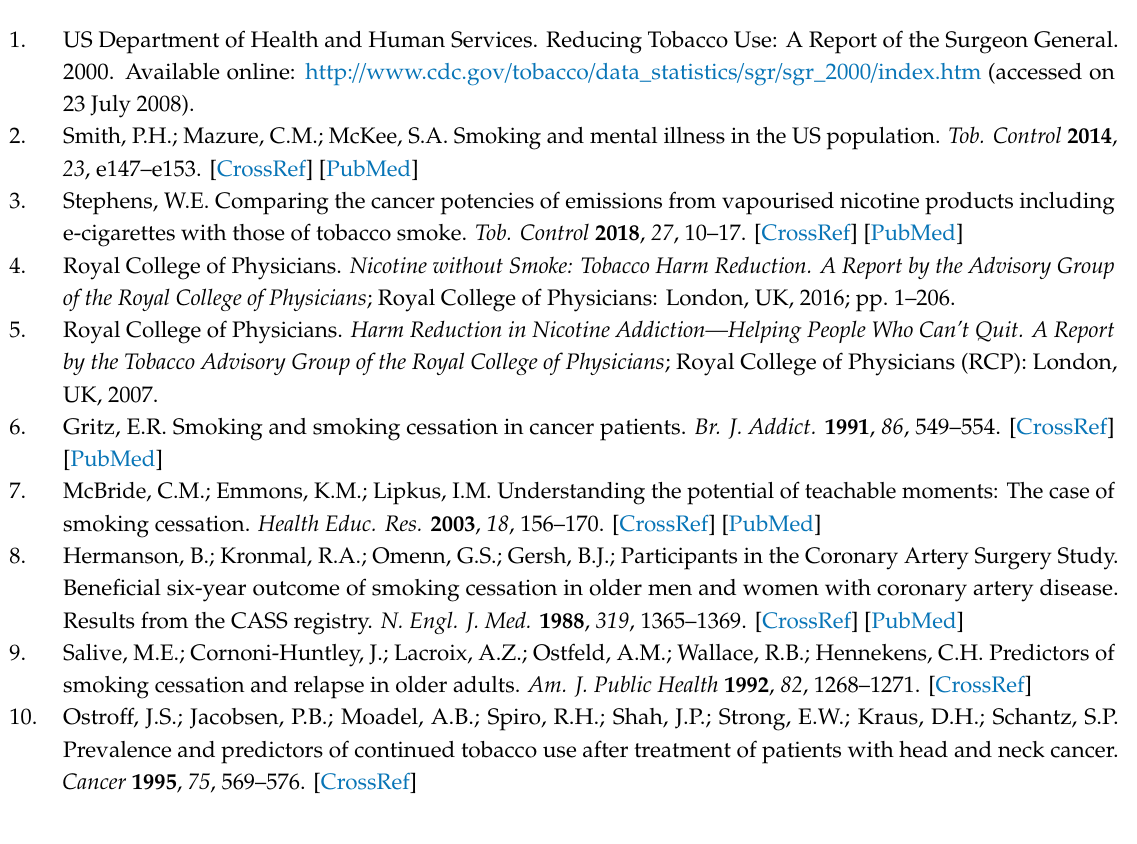
Table S1: Association between self-reported health problems and use of vaping on the last quit attempt among current daily